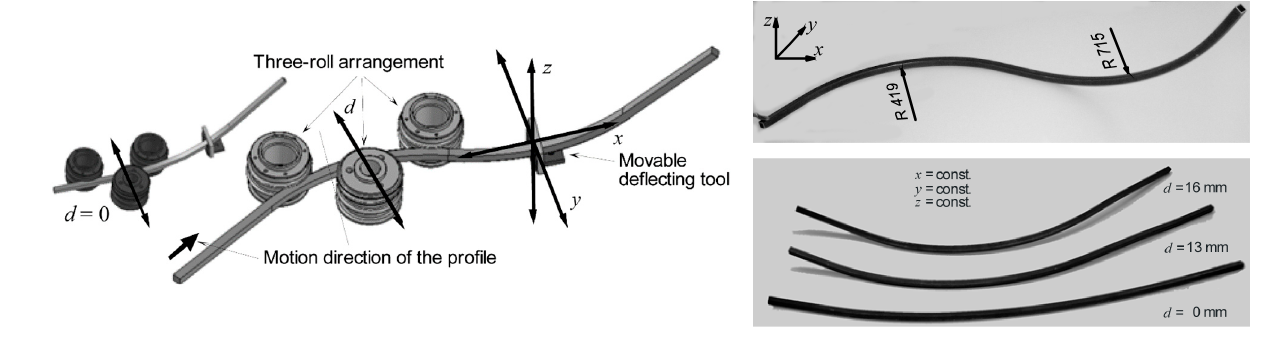
( b ) Formed profiles and effect of d on curvature. ( a ) Schematic illustration. Reproduced with permission from ref. [38]. Reproduced with permission from ref. [63]. Copyright 2007 Springer-Verlag Berlin Heidelberg. Figure 16. Superposed three-roll-bending with subsequent profile deflection [38,63]. A representative formed profile made of S235JR steel is shown in Figure 16b. By